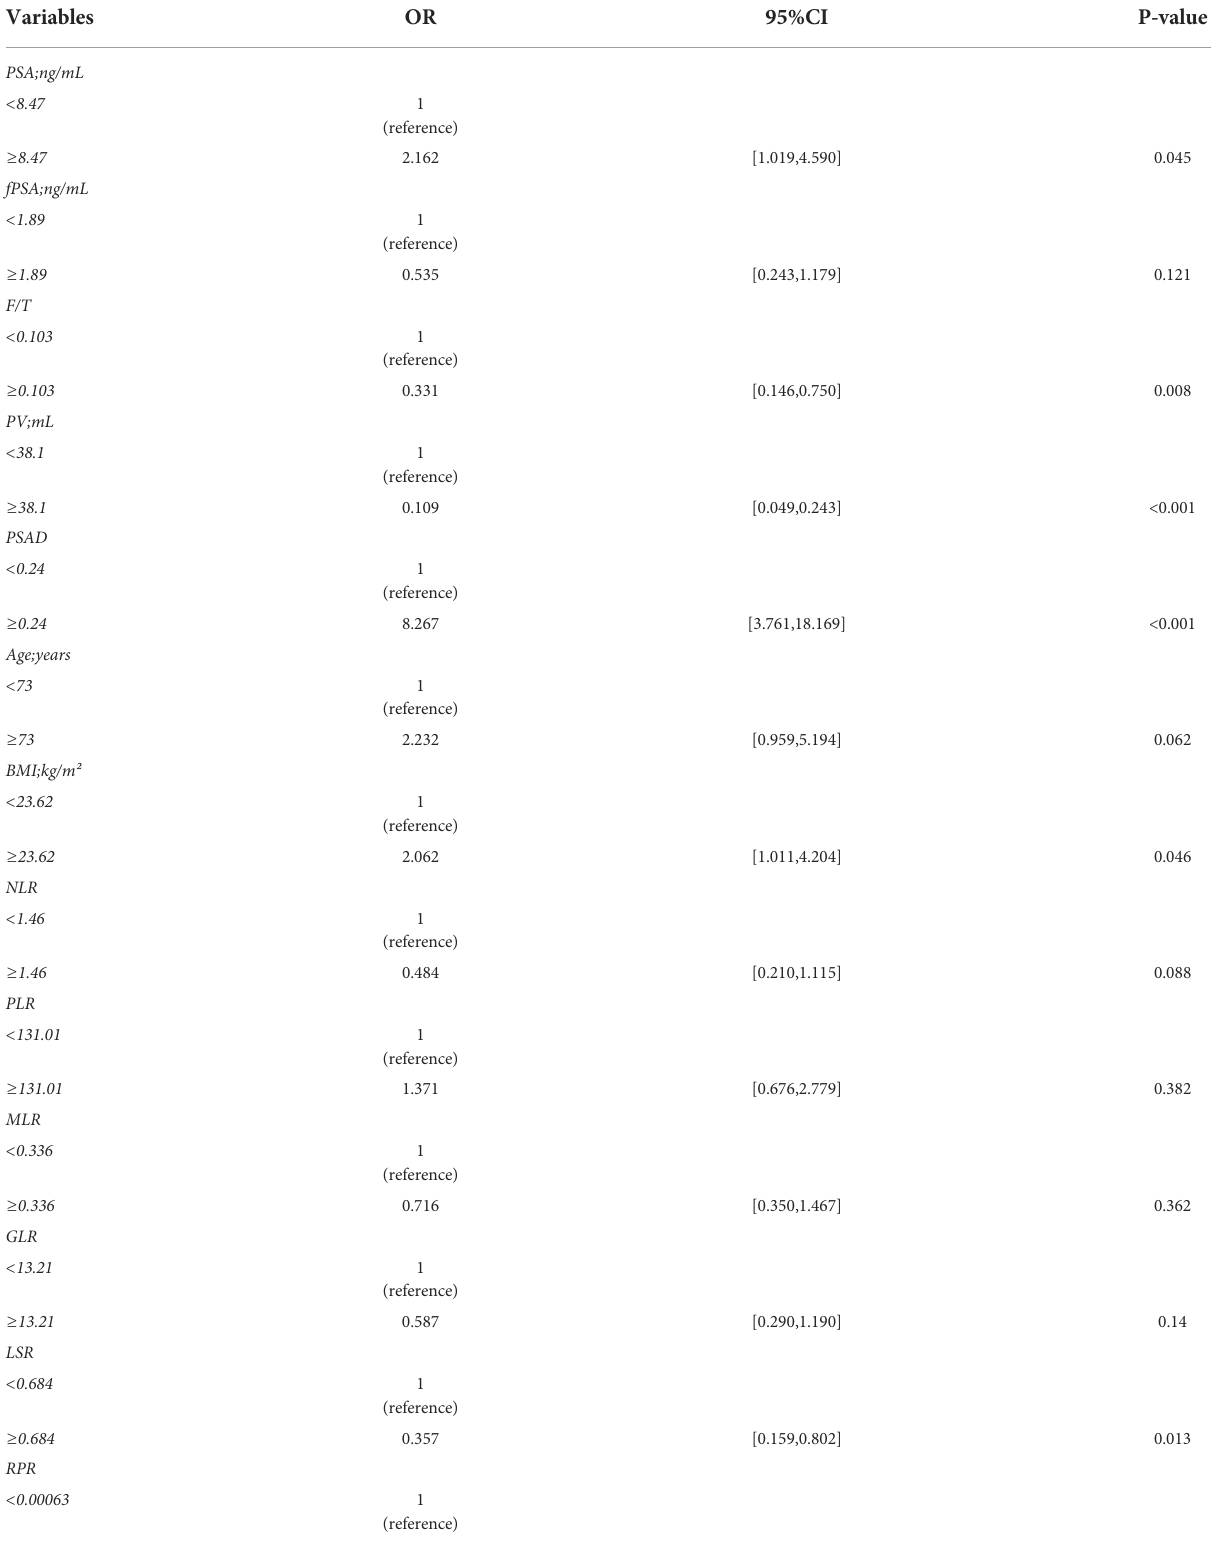
TABLE 2 Univariate logistic regression in the differential diagnosis of prostate cancer in the whole data